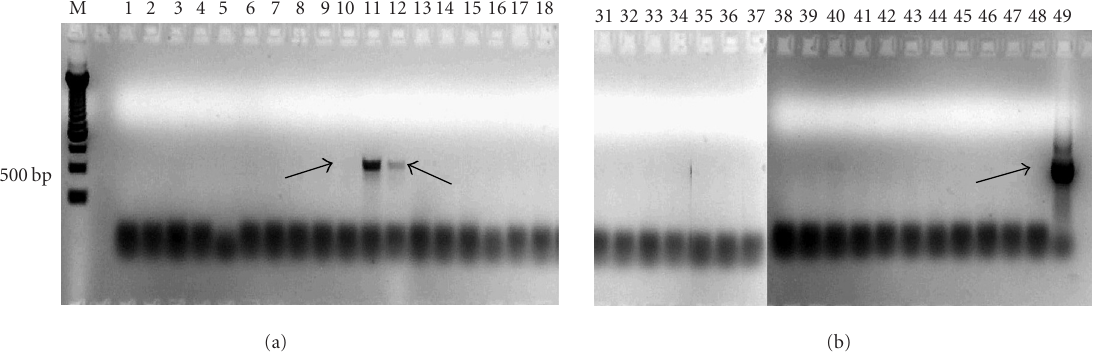
Figure 9. Transcribed pleurocidin cDNA bands at 590 b from transformed KMH 71cells at days 5 and 6 (+RT) and gel containing transformed KMH 71 cells ( − RT); positive control shown in lane